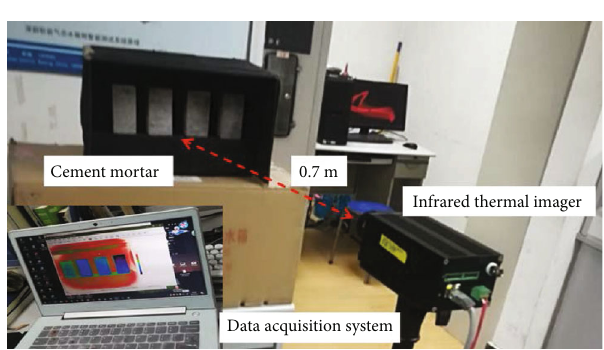
Figure 4: Experimental data acquisition system.